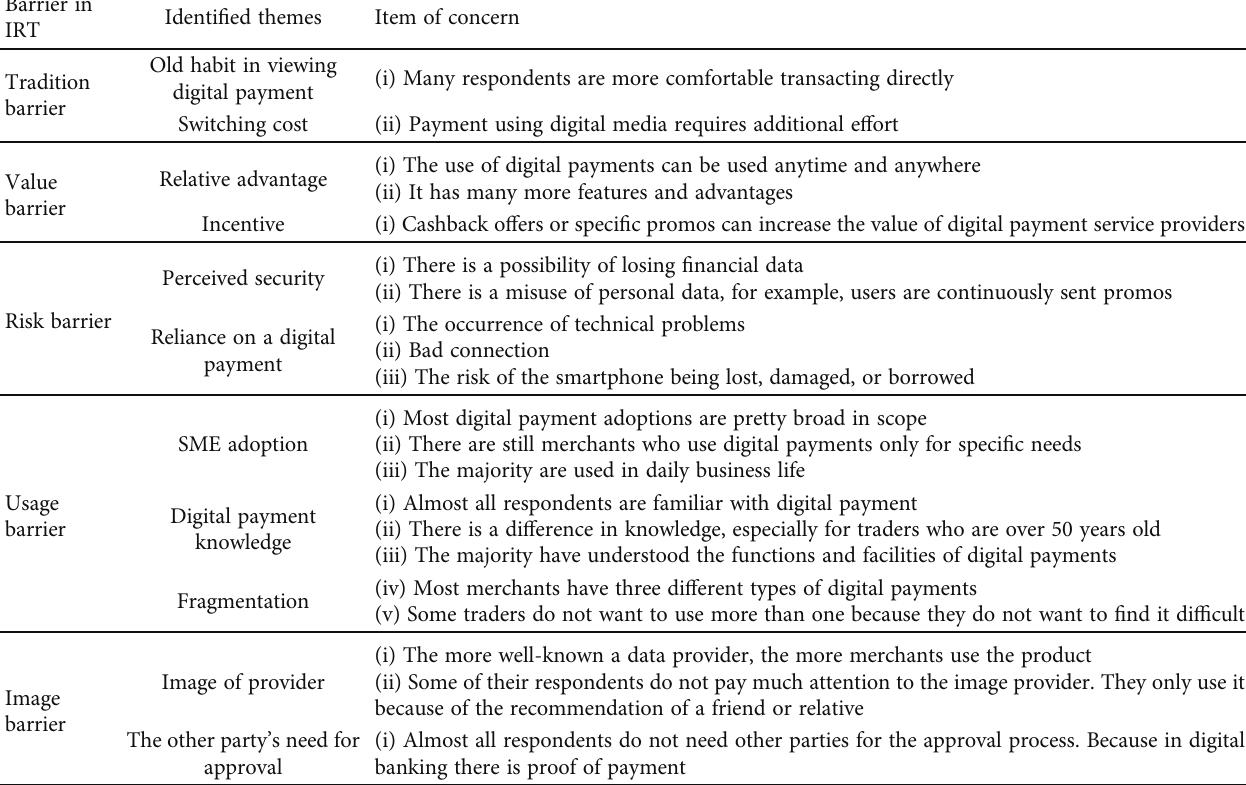
Table 3: Item of